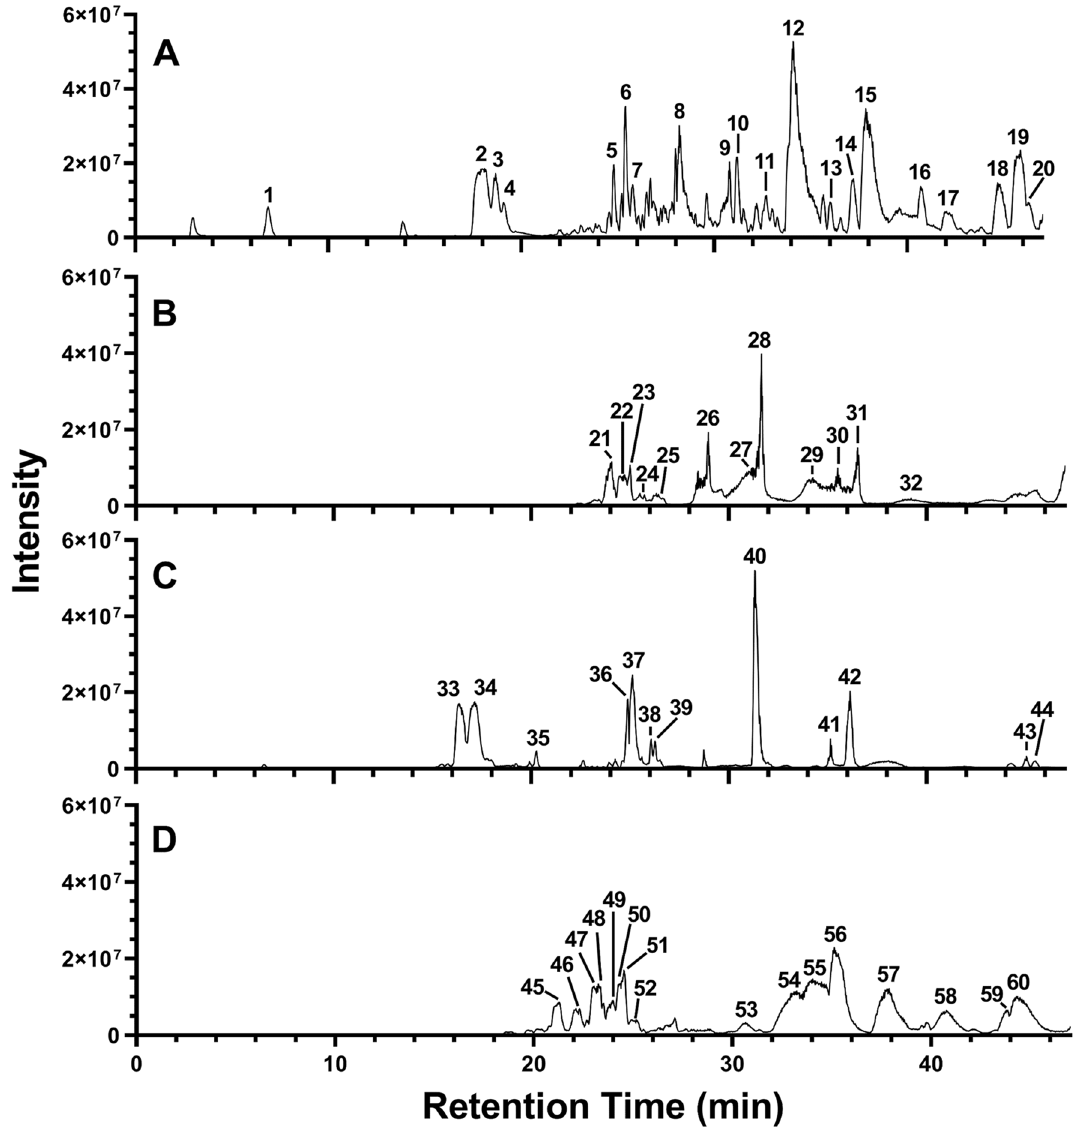
Figure 5. The ESI negative mode base peak LC-FTMS chromatogram for ( A ) etE011-18, H. madagascariensis , ( B ) hE004-18, S. calycinum subsp. angustifolium , ( C ) eE006, S. aculeastrum , and ( D ) dietE017a, Z. chalybeum